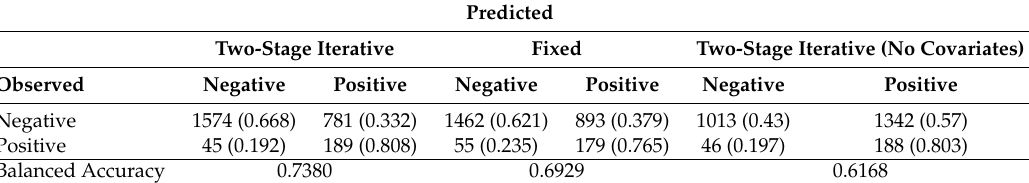
Table A4. Confusion matrix. Cut-off point = 0.079.